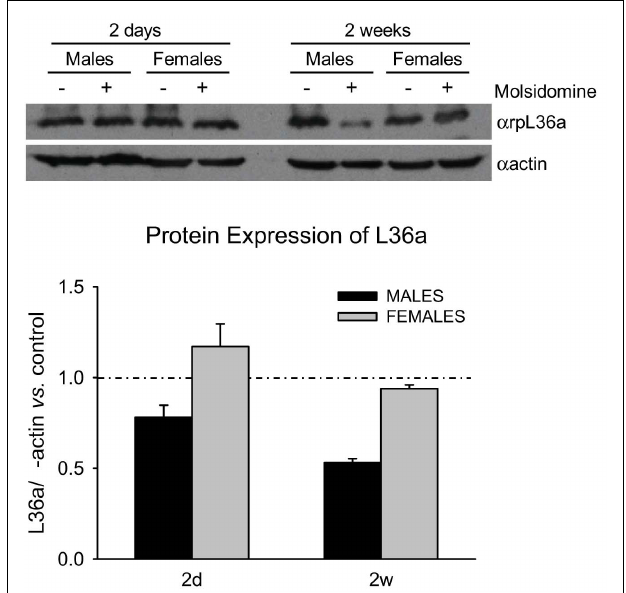
FIGURE 3 |Western Blot on ribosomal protein L36a. Western blot analysis was performed on kidneys lysates from 2day and 2week control and molsidomine FHH rats of both genders using an antibody against ribosomal protein L36a (upper panel).The measured band intensity of ribosomal protein L36a was normalized by α -actin of the same sample (ribosomal protein L36a/actin).The molsidomine effect on ribosomal protein L36a/actin is expressed relative to the age- and gender matched control, shown in graph by the dotted line (lower panel).The reduction in 2week molsidomine males is borderline significant ( P = 0.1). All 3 replicates are